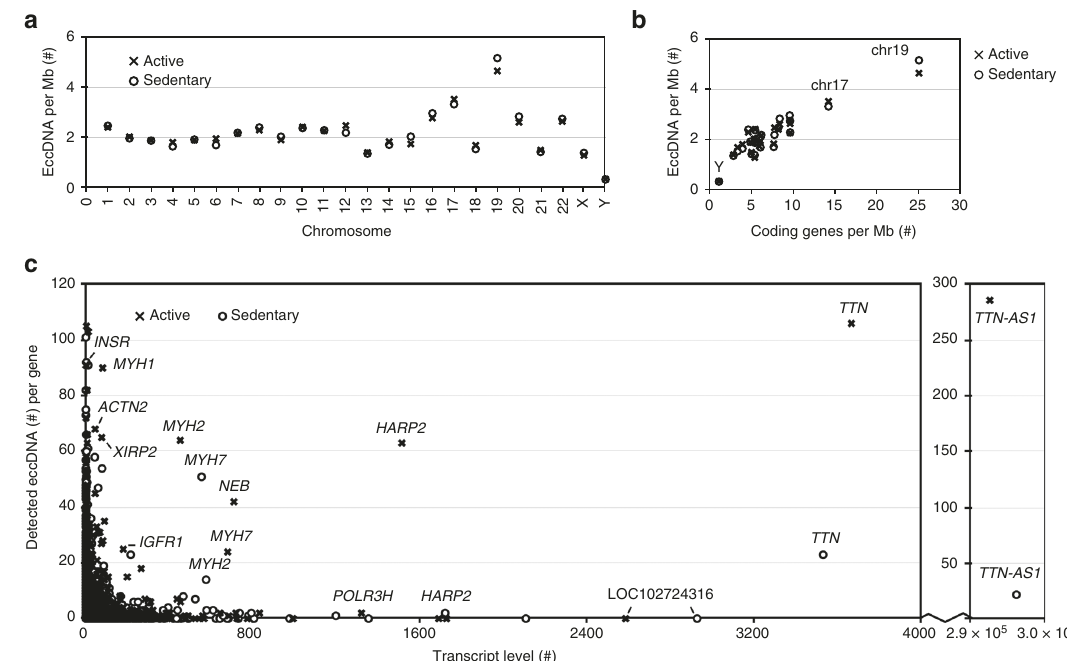
Fig. 5 EccDNA frequency relative to chromosome, gene density and transcription. Muscle-derived eccDNA counts per Mb from physically active (x, n = 8) and inactive men (o, n = 8) per: a chromosome and b coding genes per Mb (chromosome Y, 17 and 19 are marked). c EccDNA counts per gene relative to average transcription level of muscle sample (two sets, each group n =